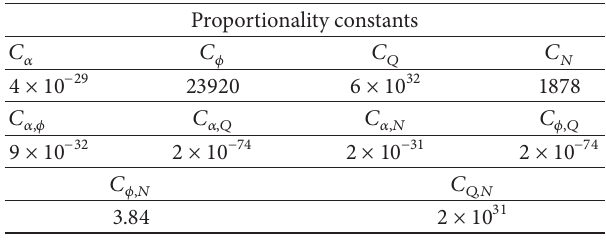
Table2:Thistableoutlinesthevariousproportionalityconstantsfor the system of (9) and (11) as rewritten in (12) and